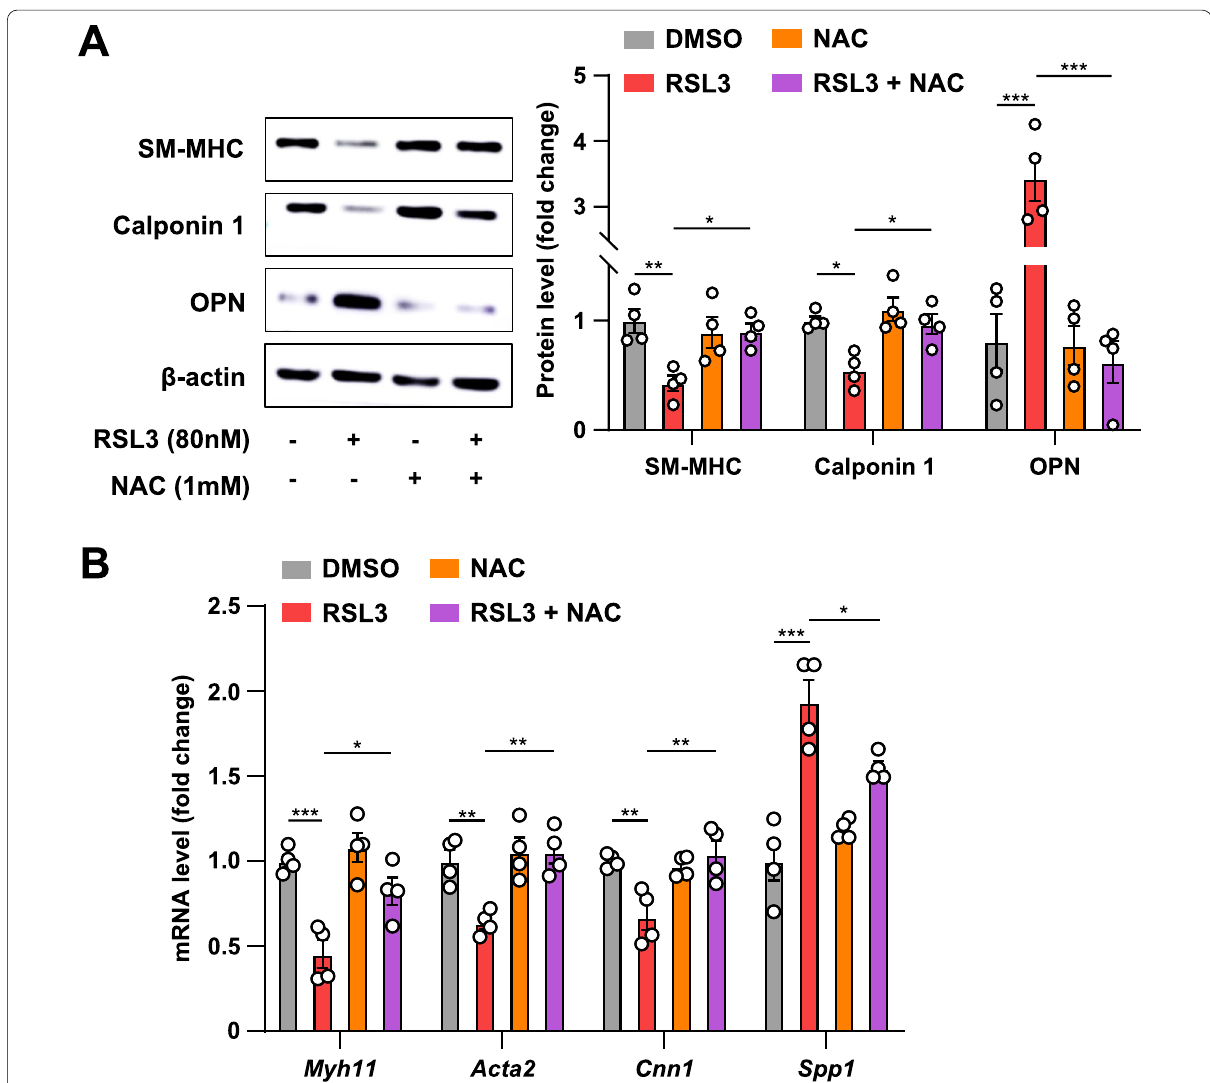
Fig. 6 ROS scavenger NAC abolishes RSL3‑induced rat VSMC phenotypic switching. A , B Rat VSMCs were pretreated with NAC (1 mM) for 15 min and/or RSL3 (80 nM) for an additional 24 h and subjected to the following analyses. A The representative Western blots and densitometric quantification of SM‑MHC, calponin 1, and OPN ( n